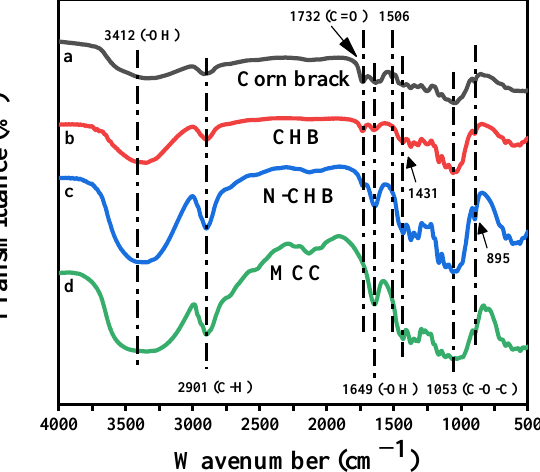
Figure 4. Infrared spectra: (a) Corn bract; (b) CHB cellulose; (c) N-CHB cellulose; (d)